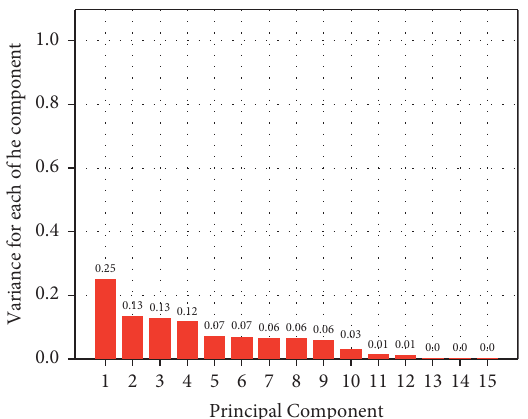
Table 5: Summary of the results obtained from the execution of the first experiment with p -value ≤ 0.05.